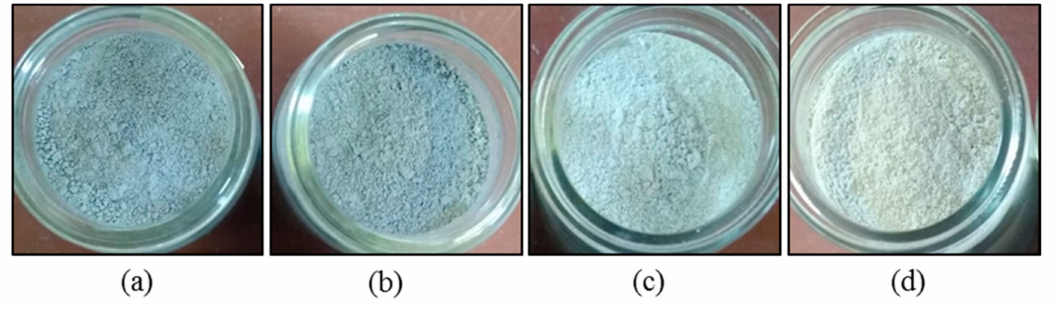
Figure 3. Rice husk ashes after grinding: ( a ) U1, ( b ) U2, ( c ) C450 and ( d ) C650.